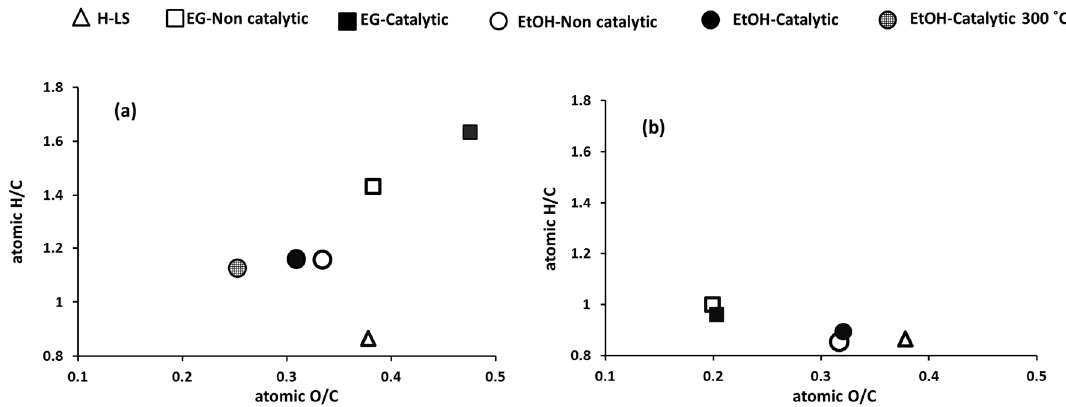
Figure 5. Van Krevelen diagrams of ( a ) oil and ( b ) solid fractions from conversion of H-LS in EtOH and EG media. Reaction condition: 0/0.75 g catalyst, 7.5 g H-LS, 75 mL solvent, initial H 2 loading of 50 bar at RT, reaction temperature of 250 ◦ C (except for conversion of H-LS in EtOH at 300 ◦ C), 3 h reaction time.